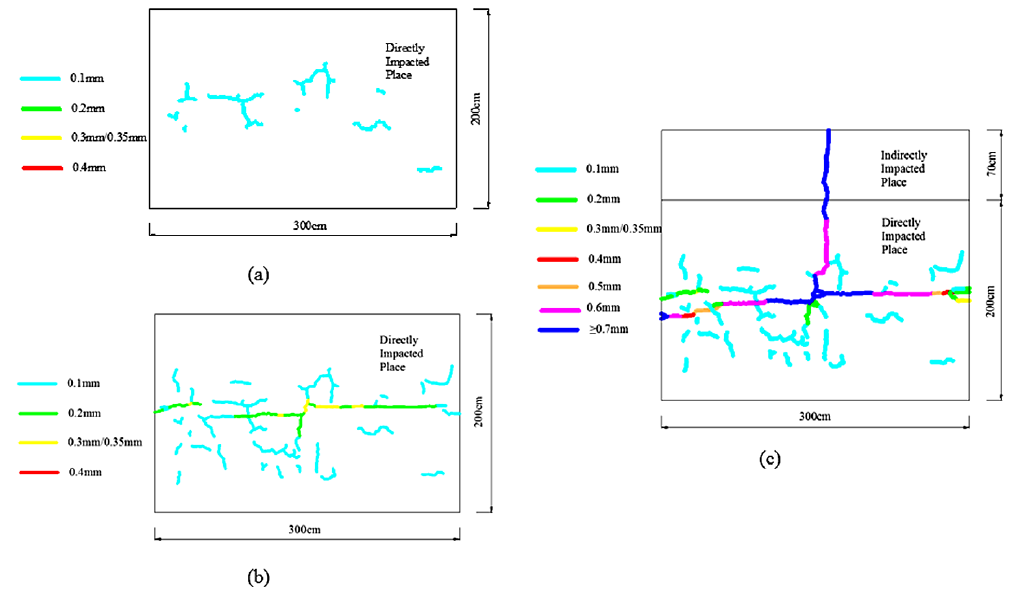
Figure 5. Distribution of the cracks on the element in series C ( a , b and c represent the C1, C2 and C3,